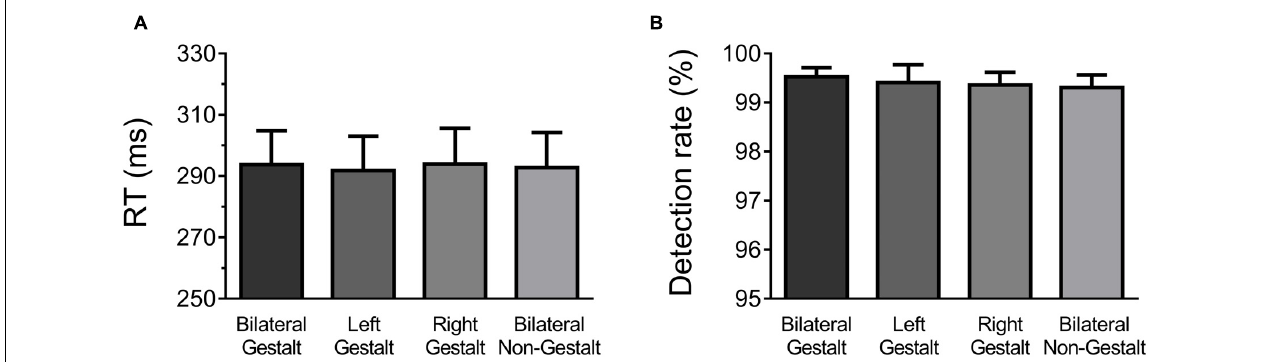
FIGURE 2 | Behavioral results. (A) Mean response times (RT) and across-subject standard error of the mean for each experimental condition. (B) Mean detection rates and across-subject standard error of the mean for each experimental condition.